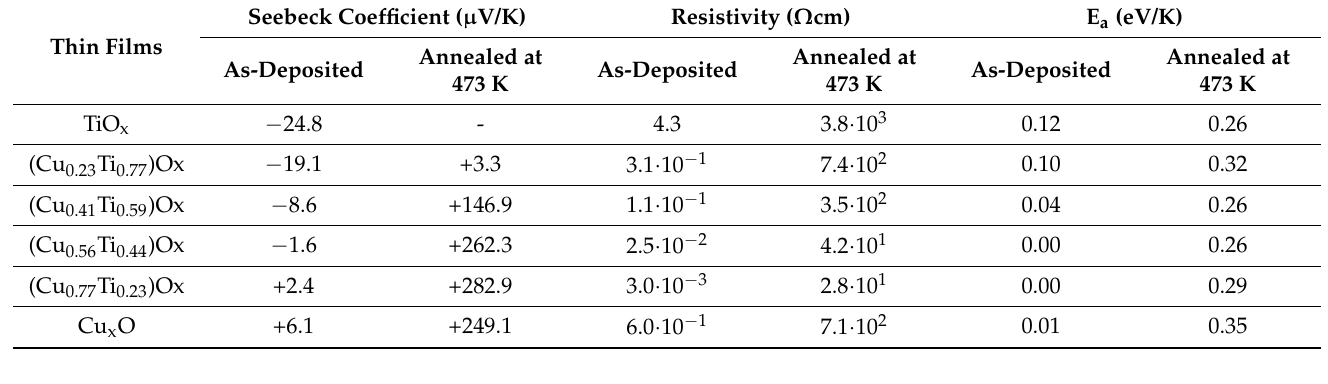
Table 3. Electrical parameters of as-deposited and annealed at 473 K (CuTi)Ox thin films.